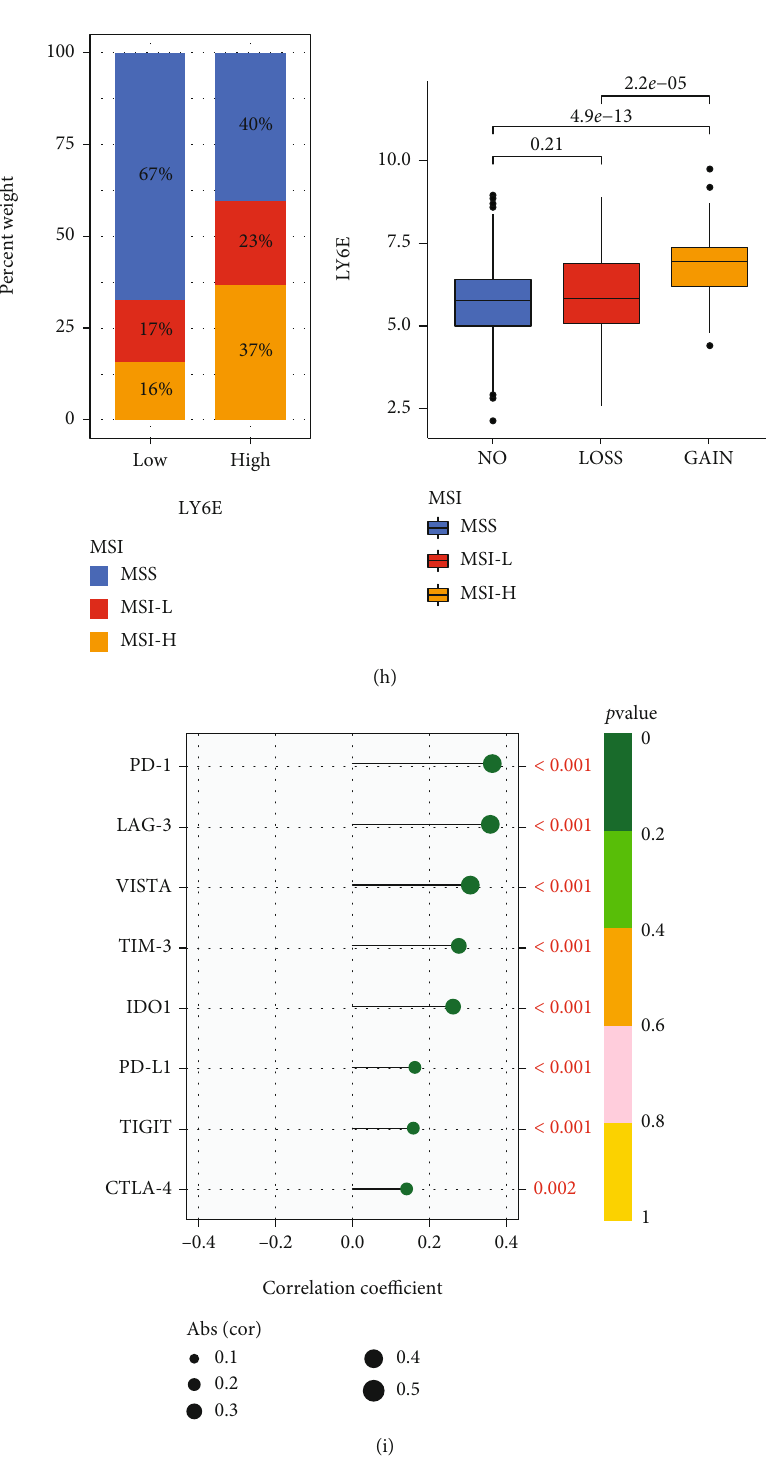
Figure 2: Prognostic predictive value of LY6E. (a) The Kaplan – Meier curve showed that high LY6E mRNA expression is signi fi cantly associated with poor overall survival and (b) progress-free survival compared with low expression. (c) The GSE17538 and (d) GSE38832 datasets show that patients with high LY6E expression were closely correlated with poorer overall survival. (e) Univariate and (f) multivariate Cox regression analyses estimating prognostic value of LY6E. (g) The rate of copy number gain and (h) MSI-H was higher in the LY6E high-expression group. (i) The mRNA expression of LY6E is positively correlated with immune checkpoint molecules expression